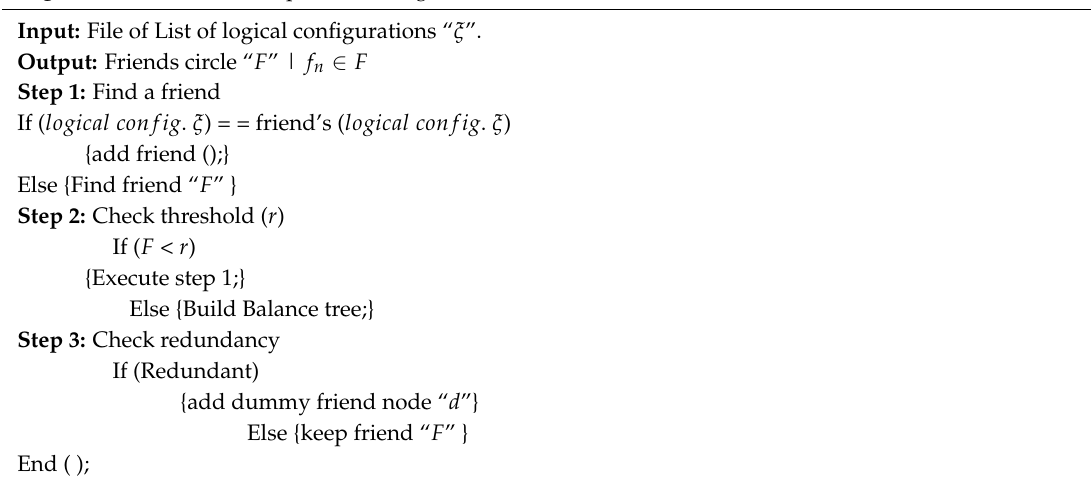
Algorithm 1. The friendship selection